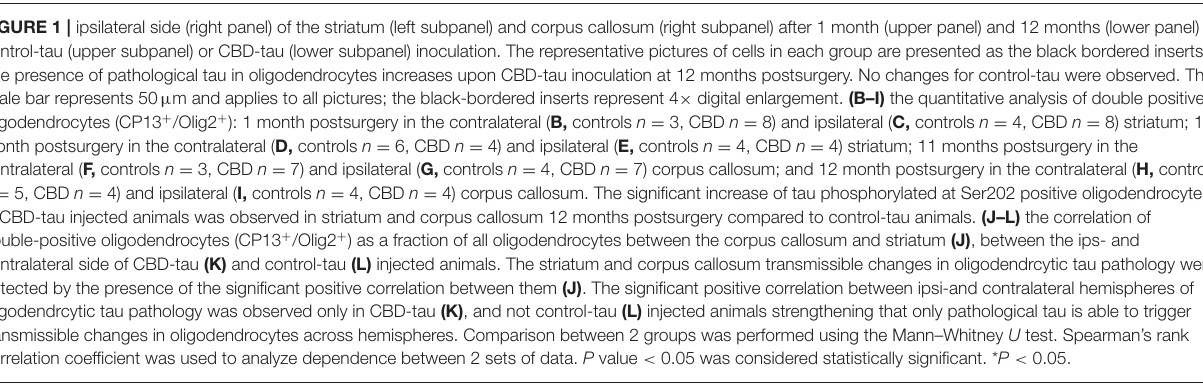
FIGURE 1 | ipsilateral side (right panel) of the striatum (left subpanel) and corpus callosum (right subpanel) after 1 month (upper panel) and 12 months (lower panel) of control-tau (upper subpanel) or CBD-tau (lower subpanel) inoculation. The representative pictures of cells in each group are presented as the black bordered inserts. The presence of pathological tau in oligodendrocytes increases upon CBD-tau inoculation at 12 months postsurgery. No changes for control-tau were observed. The scale bar represents 50 µ m and applies to all pictures; the black-bordered inserts represent 4 × digital enlargement. (B–I) the quantitative analysis of double positive oligodendrocytes (CP13 + /Olig2 + ): 1 month postsurgery in the contralateral ( B, controls n = 3, CBD n = 8) and ipsilateral ( C, controls n = 4, CBD n = 8) striatum; 12 month postsurgery in the contralateral ( D, controls n = 6, CBD n = 4) and ipsilateral ( E, controls n = 4, CBD n = 4) striatum; 11 months postsurgery in the contralateral ( F, controls n = 3, CBD n = 7) and ipsilateral ( G, controls n = 4, CBD n = 7) corpus callosum; and 12 month postsurgery in the contralateral ( H, controls n = 5, CBD n = 4) and ipsilateral ( I, controls n = 4, CBD n = 4) corpus callosum. The significant increase of tau phosphorylated at Ser202 positive oligodendrocytes in CBD-tau injected animals was observed in striatum and corpus callosum 12 months postsurgery compared to control-tau animals. (J–L) the correlation of double-positive oligodendrocytes (CP13 + /Olig2 + ) as a fraction of all oligodendrocytes between the corpus callosum and striatum (J) , between the ips- and contralateral side of CBD-tau (K) and control-tau (L) injected animals. The striatum and corpus callosum transmissible changes in oligodendrcytic tau pathology were detected by the presence of the significant positive correlation between them (J) . The significant positive correlation between ipsi-and contralateral hemispheres of oligodendrcytic tau pathology was observed only in CBD-tau (K) , and not control-tau (L) injected animals strengthening that only pathological tau is able to trigger transmissible changes in oligodendrocytes across hemispheres. Comparison between 2 groups was performed using the Mann–Whitney U test. Spearman’s rank correlation coefficient was used to analyze dependence between 2 sets of data. P value < 0.05 was considered statistically significant. * P <